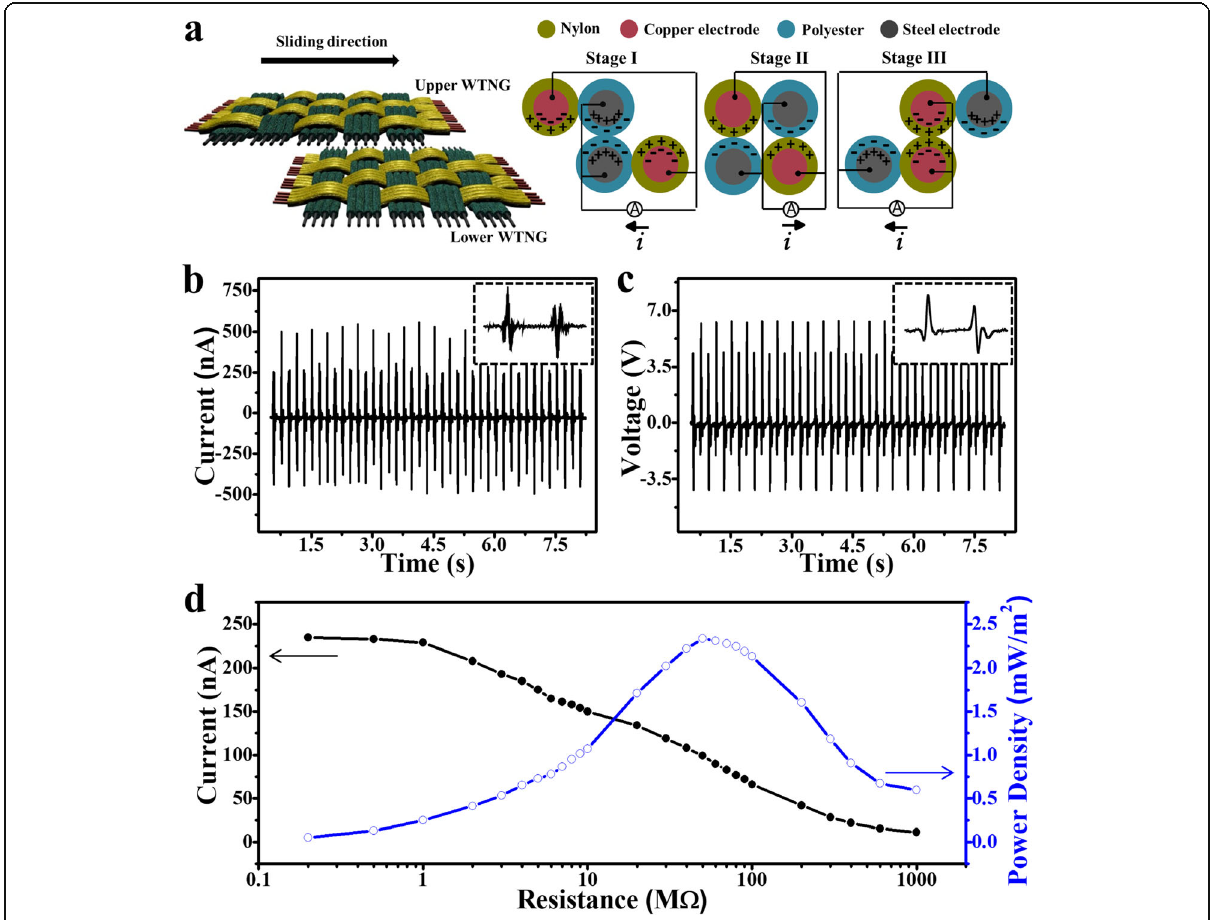
Fig. 2 Power generation characteristics of the 2DW-WTNG. a Overall process of the electricity generation mechanism. b Output current and c output voltage of the 2DW-WTNG. The inserts in b and c are enlarged views of the output current and output voltage. d Current (solid circle) and power density (open circle) of the 2DW-WTNG with different load